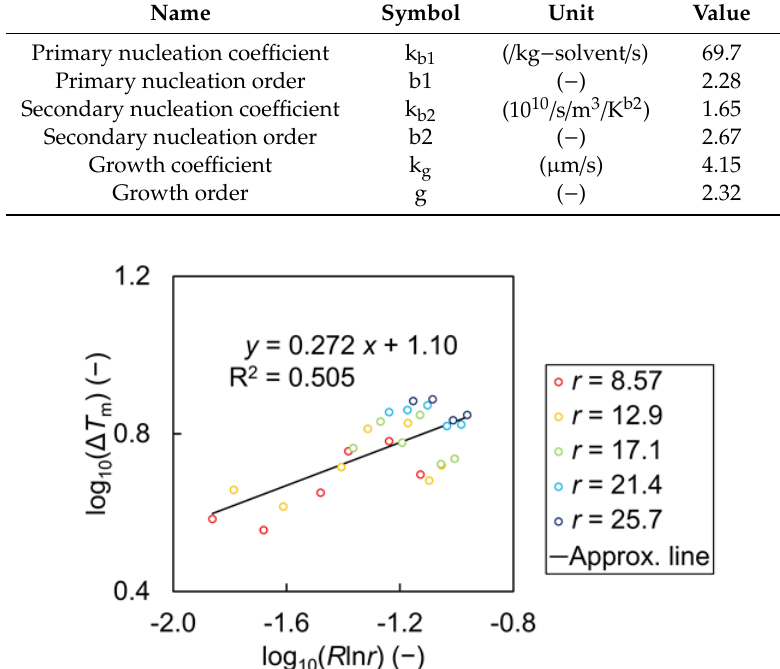
Figure 4. The regression analysis expressed in Equation (21) for the estimation of the kinetic parameters of the secondary nucleation.